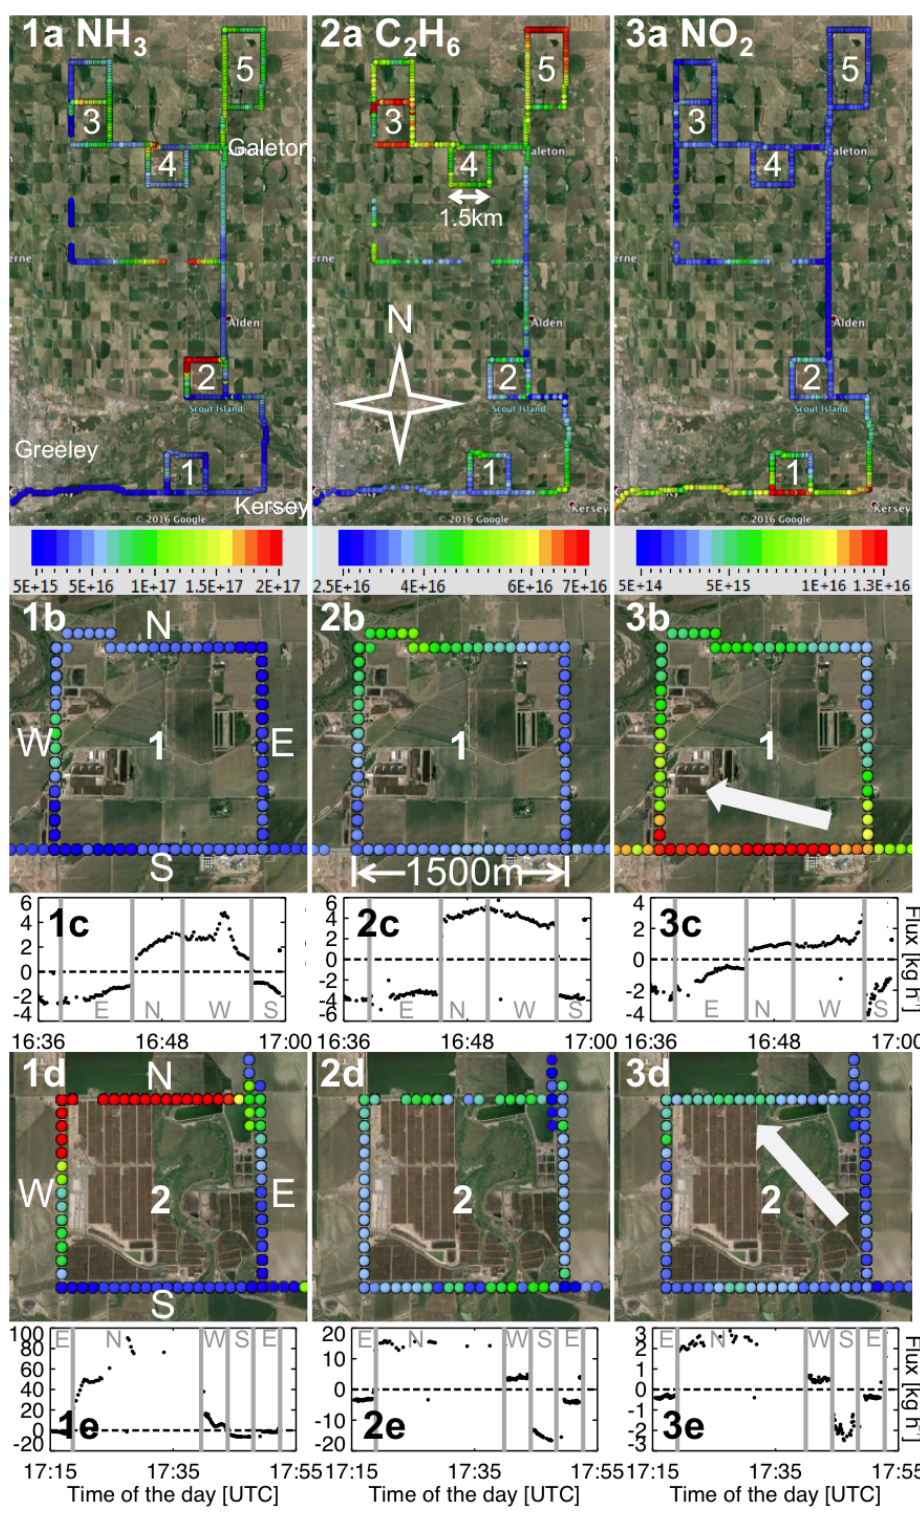
Figure 8. Zoom of the area east of Greeley, CO, with the RD11 drive track color coded by the VCD of (left column, 1) NH 3 , (middle, 2) C 2 H 6 and (right, 3) NO 2 . Row (a) shows the five sites of interest, (b) shows site 1 and (d) shows site 2 from Fig. 6. Rows (c) and (e) show a time series of the flux, calculated using Eq. (1); the arrows in (3b) and (3d) indicate the mean wind direction at each site. (Background image from Google Earth